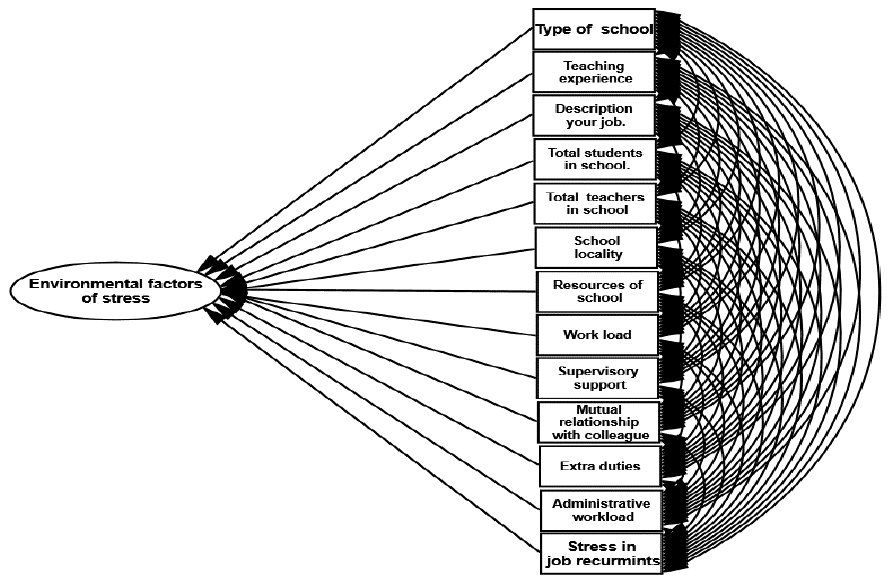
Figure 12. Hypothetical model of environment factors.